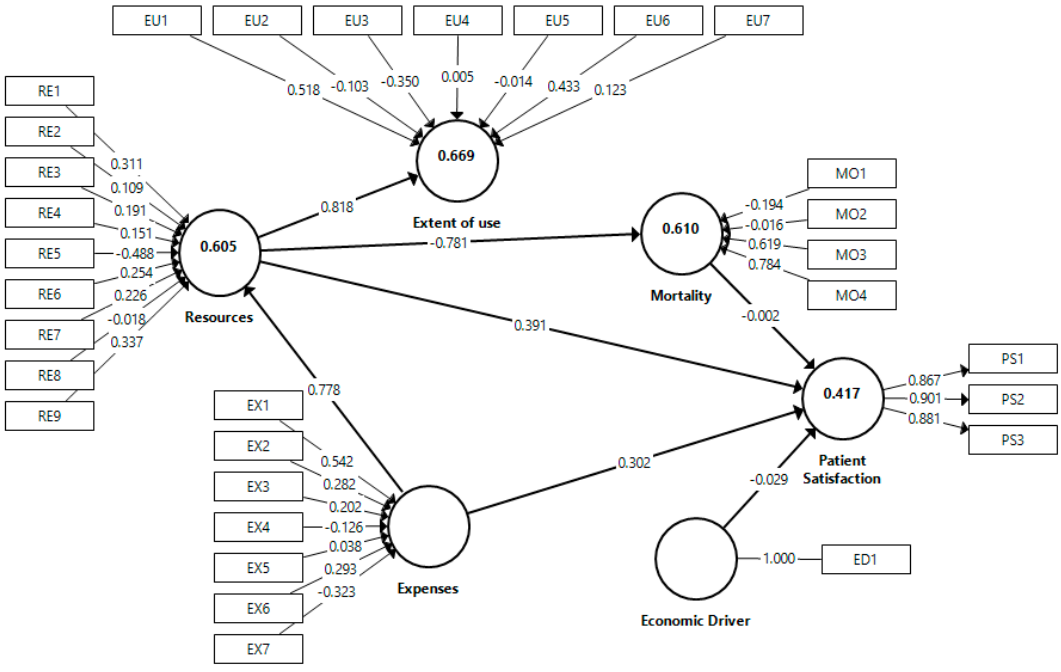
Figure 2. Whole model results for men.